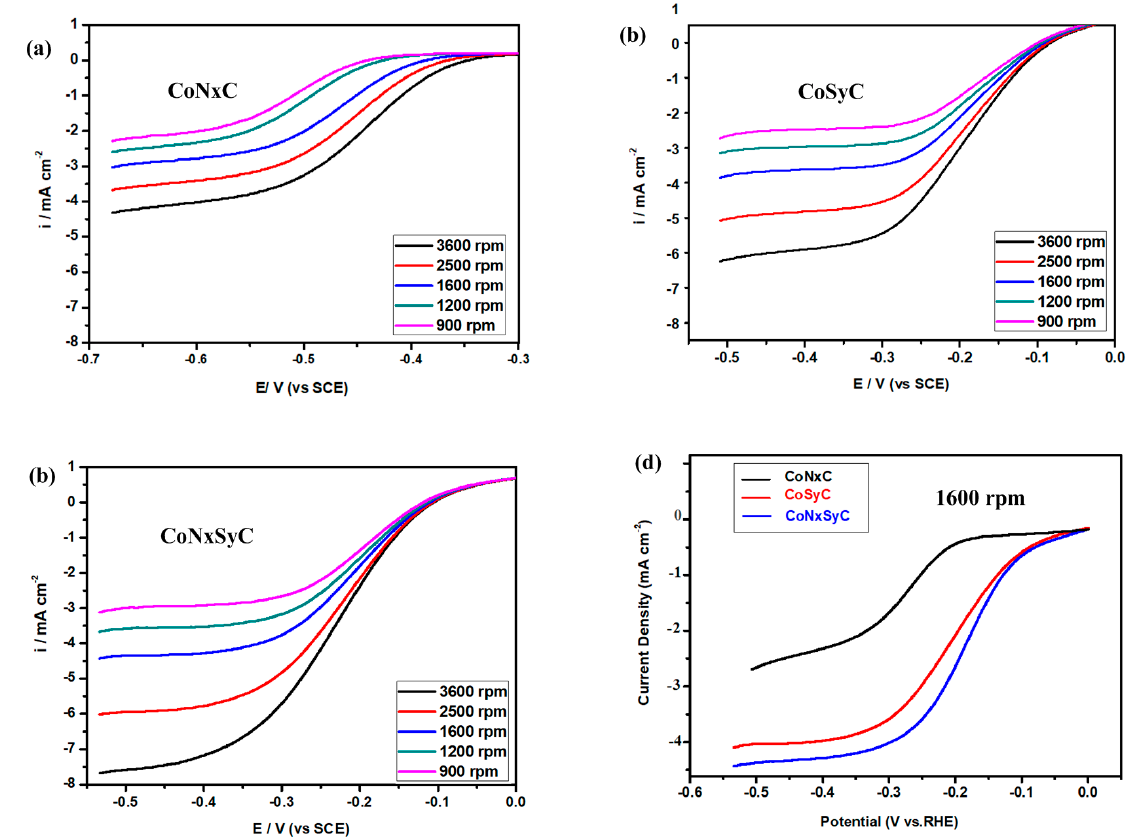
Figure 6. Linear sweep voltammetry (LSV) curves at all rpms of ( a ) CoNxC ( b ) CoSyC ( c ) CoNxSyC ( d ) LSV curves at 1600 rpm of all catalysts.